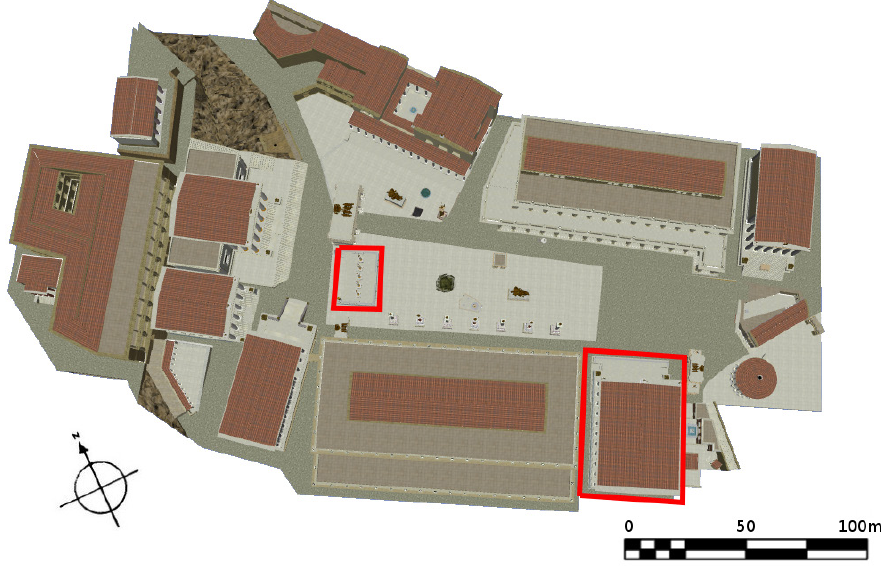
Figure 1. A top-down view of the model of Forum Romanum used in the study. The temple of Divus Iulius has been removed from the model, as explained in the text.